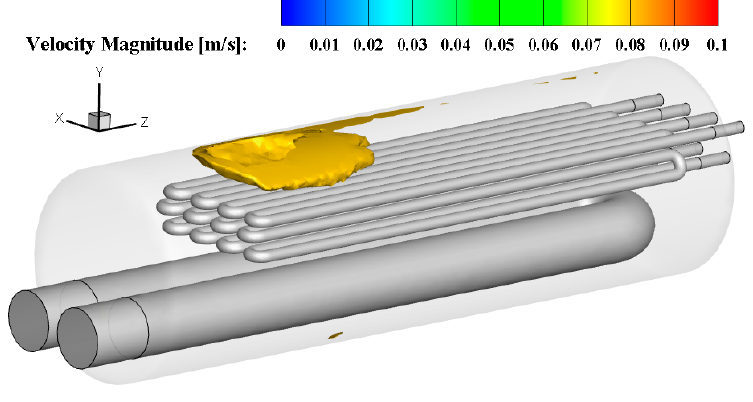
Figure 17. The iso-surfaces of velocity magnitude with various values inside the water tank of the heater under consideration.